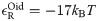
Transcription activity data of simple repression and looping regulated genes.Transcription activity data for the simple repression architecture from [17, 37], as previously shown in [38], as well as data for the looping scenario from [55, 56], rescaled to the scaling factor z appropriate to its architecture. For simple repression scenarios, z = λR exp(−βϵR). For the looping scenario, zL is calculated using Eqs (18) and (26). The solid blue line signifies the scaling function (1 + z)−1. The repressor binding energies are taken from [37] as ϵROid=-17kBT, ϵRO1=-15.3kBT,ϵRO2=-13.9kBT and ϵRO3=-9.7kBT. Values for promoter copy numbers N and competitor sites Nc are taken from [17] (simple repression) and [55] (looping). The value for the looping free energy, FL = +9.1kBT, was taken from Fig 3b in [55] as the average looping free energy for a loop that has a length in between 76 and 84 base pairs. For each data set, λR is calculated by solving the mass balance appropriate for the architecture, Eq (7) (simple repression) or Eq (24) (looping).